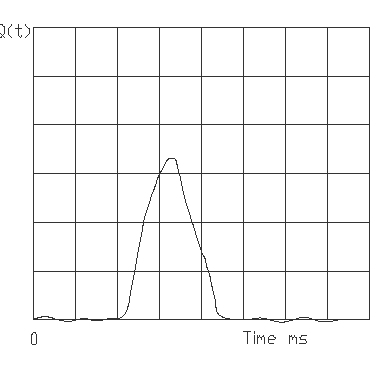
Fig. 5c: n=700 rpm, Q 3 = 28 mm 3